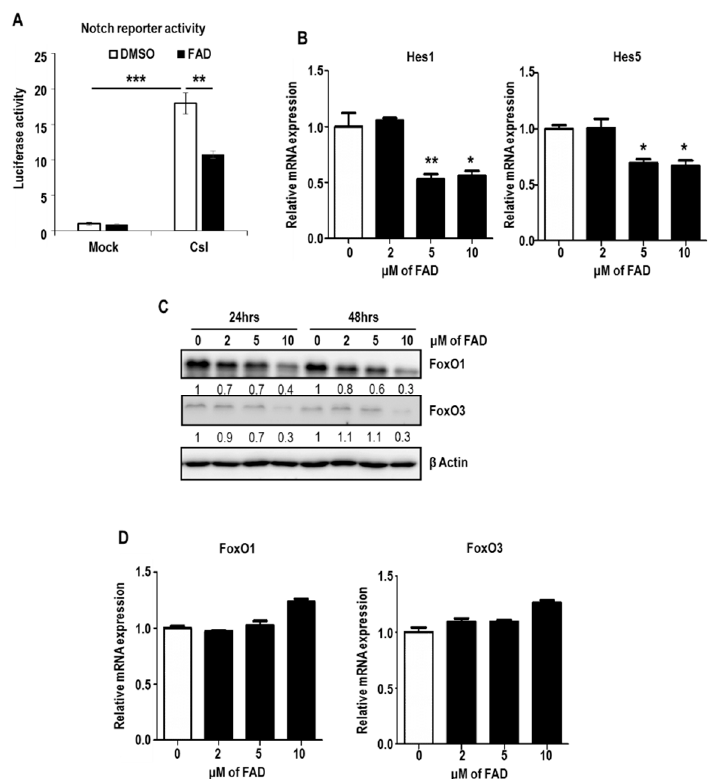
Figure 5. Downregulation of FoxO-Notch axis in NSCs by FAD. ( A ) Csl-induced luciferase reporter activity was measured in DMSO or FAD treated NSCs. Statistical differences were considered significant when ** p < 0.01, and *** p < 0.001. ( B ) The mRNA expression of Hes1 and Hes5 after treatment of DMSO or FAD in NSCs, as measured by real-time RT-PCR analysis. The mRNA level of DMSO-treated cells was set to 1. Representative results from multiple experiments are shown. Statistical significance was determined by unpaired t -test. * p < 0.05, and ** p < 0.01. ( C ) Western blot analysis of FoxO1 and FoxO3 in NSCs after treatment of DMSO or FAD for 24 h or 48 h. β Actin was used as a loading control. The relative band intensities of each proteins are shown below the bands. The intensities of vehicle treated lane were arbitrarily set as 1. ( D ) The mRNA expression of FoxO1 and FoxO3 after treatment of DMSO or FAD in NSCs, as measured by real-time RT-PCR analysis. The mRNA level of DMSO-treated cells was set to 1. Representative results from multiple experiments are shown.